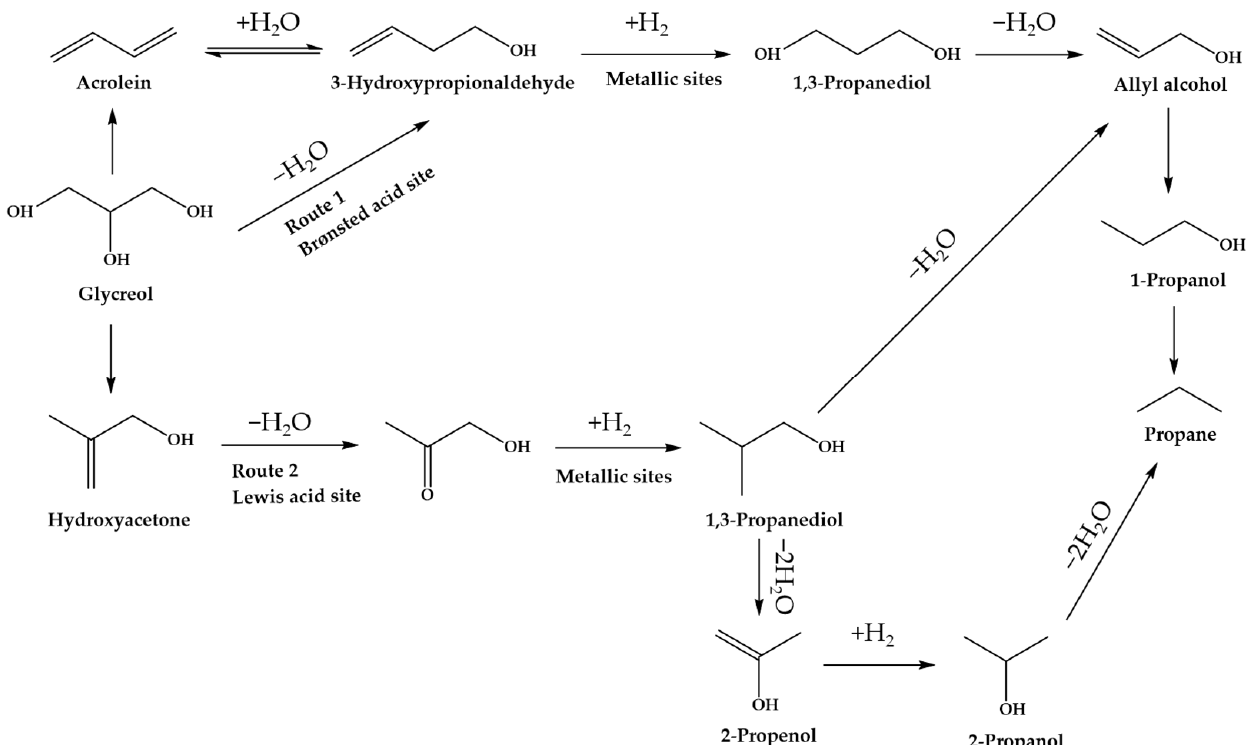
Figure 11. General reaction routes involved in the hydrogenolysis of glycerol [142].